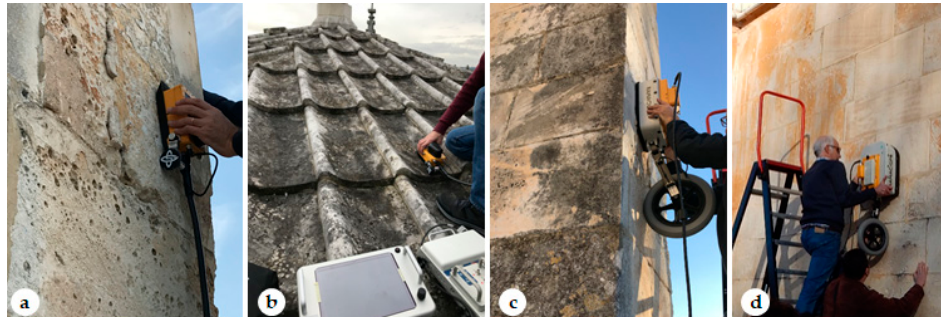
Figure 5. GPR system used for data acquisition and collection of GPR profiles through the main façade of MB ( a ) 2300 MHz antenna, ( c ) 800 MHz antenna, ( d ) 500 MHz antenna and roof of the Founder’s Chapel ( b ). Table 1. GPR acquisition setup.